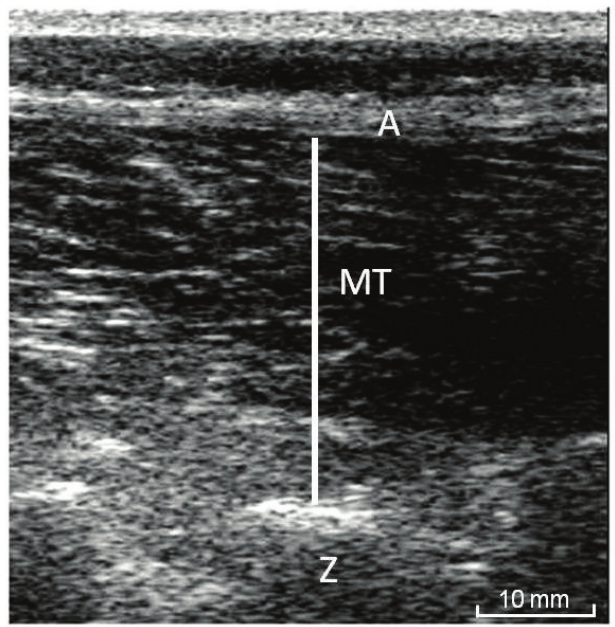
Figure 2. Ultrasound image of the multifidus muscle thickness. Z= L4-5 zygapophyseal joint; A= aponeurosis; MT: multifidus muscle thickness.